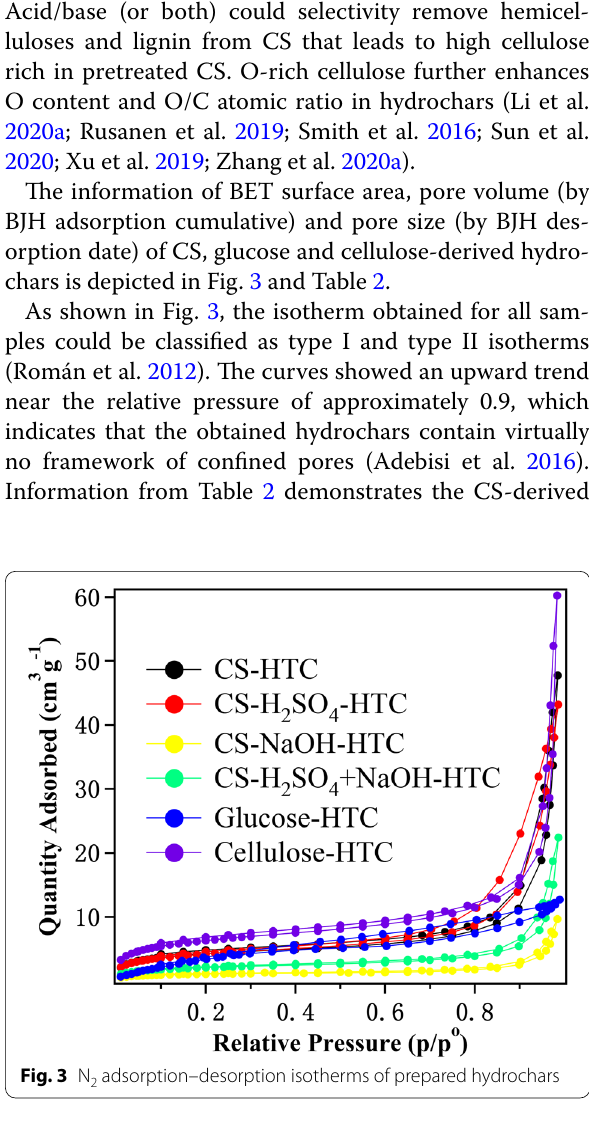
Table 1 Elemental composition of CS, glucose and cellulose-derived hydrochars Samples Elemental composition (wt%)